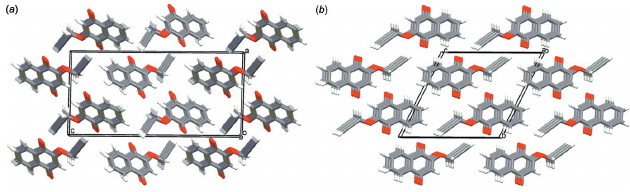
Figure 1 ( a ) The molecular structure of the title compound (monoclinic form) with the atom labelling. Displacement ellipsoids of non-H atoms are drawn at the 50% probability level. ( b ) A view of the overlay of the molecular structures of the monoclinic and triclinic forms of the title compound.